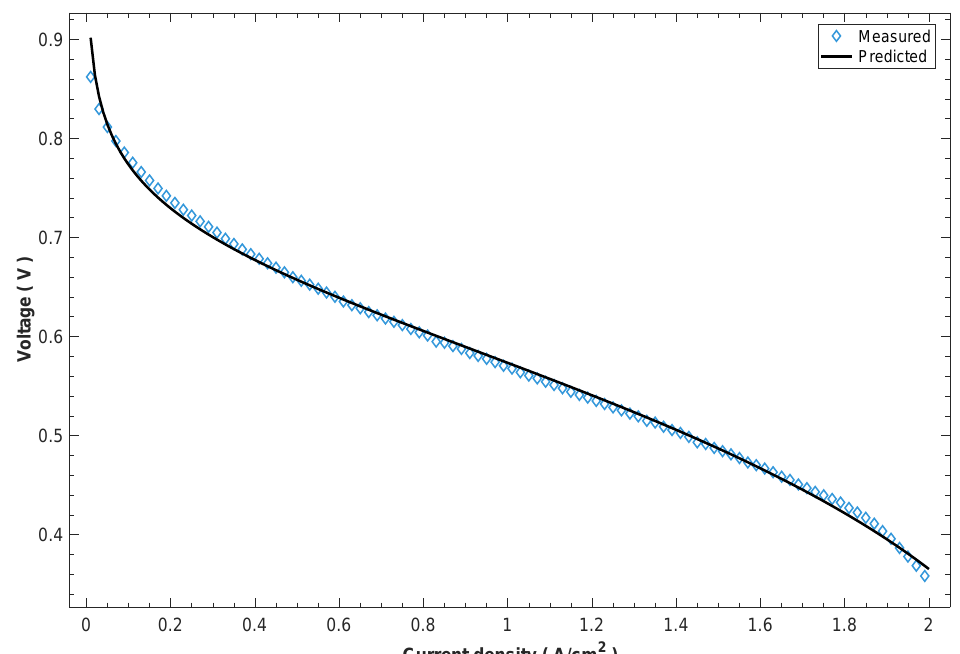
Figure 8. Modeled polarization curve using the computed unknown parameters through NNA, at 66% RH.